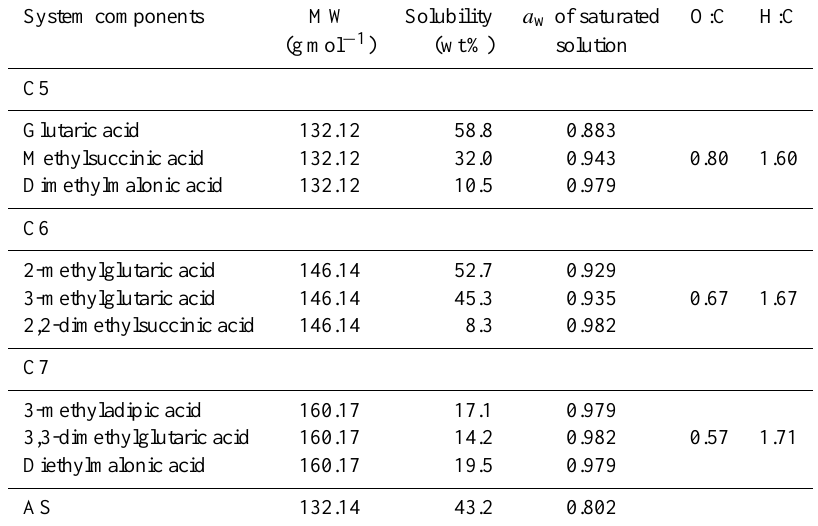
Table 1. Molecular weights (MW), aqueous solubility in weight percent at 25 ◦ C, water activities ( a w ) of saturated solutions at 25 ◦ C, oxygen-to-carbon atomic ratios (O:C) and hydrogen-to-carbon atomic ratios (H:C) of investigated dicarboxylic acids and